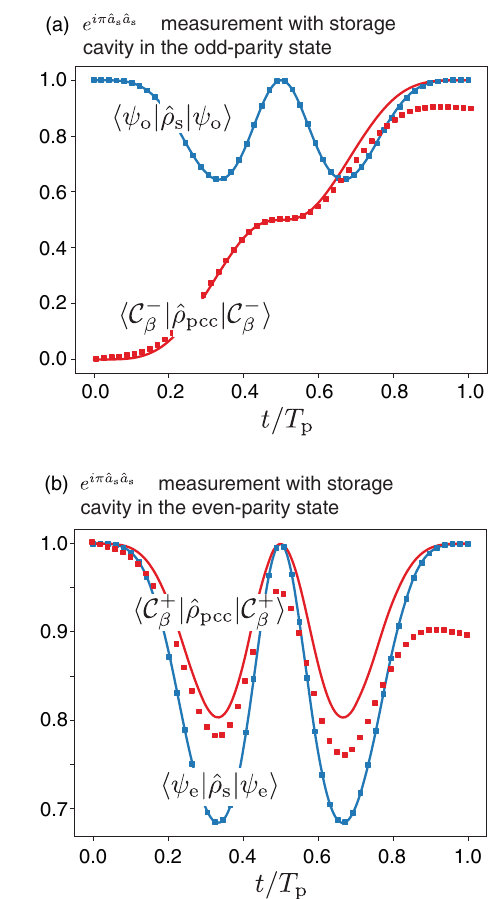
FIG. 5. The figure shows the dynamics of the PCO and the storage cat during stabilizer measurement when κ ¼ 0 (solid lines) and κ ¼ K= 200 (dots). (a) Probability for the PCO and storage oscillator to be in the state j C − β i and j ψ when their initial o i states are j C þ β i and j ψ , respectively. (b) Probability for the PCO o i when and the storage oscillator to be in the state j C − β i and j ψ e i , respectively. Here, j ψ their initial states are j C þ β i and j ψ e i o i ¼ j C − α i þ i j C − i and j ψ e i ¼ j C þ α i þ j C þ i . The parameters are i α i α χ ¼ K= 15 , P ¼ 4 K ( β ¼ 2 ), κ ¼ 0 , and T π = 4 βχ 0 . Clearly, p ¼ the state of the PCO at time T reflects the photon-number parity p of the storage cat. The probability for the PCO to correctly indicate the error syndrome is reduced to approximately 90% when κ ¼ K= 200 (red dotted lines). However, as seen from the FIG. 6. Leakage errors ( ε l ) in the PCO and the corresponding dotted blue lines, the state of the storage cat after T is unaffected p backaction ( ε ) on the storage cat due to white thermal noise (red b by single-photon loss from the PCO (the difference between the squares) and pure dephasing (blue squares). The squares are the blue dots and lines is < 10 − 3 % ). _ ˆ ρ ˆ H; ˆ ρ results of simulating the master equation (i) ¼ − i ½ (cid:2)þ D ½ ˆ a (cid:2) þ κ n D ½ ˆ a † (cid:2) and (ii) _ ˆ ρ ¼ − i ½ ˆ H; ˆ ρ (cid:2) þ κ D ½ ˆ a † ˆ a (cid:2) . κ ð 1 þ n ϕ th Þ th ˆ H is given in Eq. (24), and the solid lines are spline interpolations. 10% , κ ¼ K= 200 , κ 4000 , and P is varied between n ϕ ¼ K= th ¼ K and 16 K . χ ¼ ð π = 2 Þ χ 0 sin ð π t=T , χ 0 ¼ K= 40 , and T z Þ p ¼ β ð p þ p − 1 Þ . The reduced density matrices ˆ ρ π = 2 χ and ˆ ρ ffiffiffi 0 s PCO p 2 are evaluated at T . The size of the storage cat is α ¼ . p κ ð 1 þ n D ½ ˆ a † (cid:2) and (ii) _ ˆ ρ ¼ − i ½ ˆ H; ˆ ρ (cid:2)þ Þ D ½ ˆ a (cid:2) þ κ n th th κ D ½ ˆ a † ˆ a (cid:2) , for different pump strengths P . Here, ˆ H is given ϕ